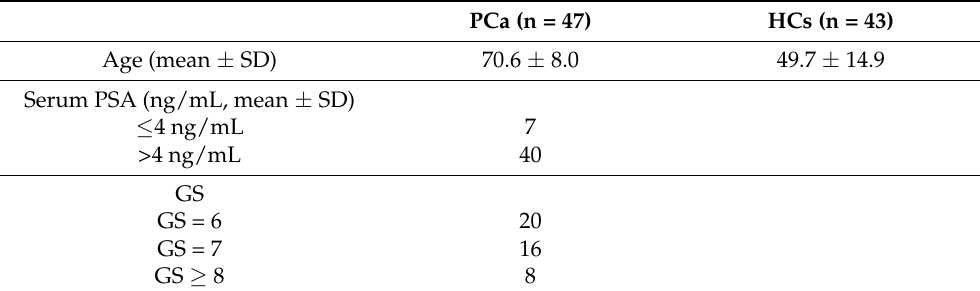
Table 6. Clinical and demographic information of the PCa and HCs